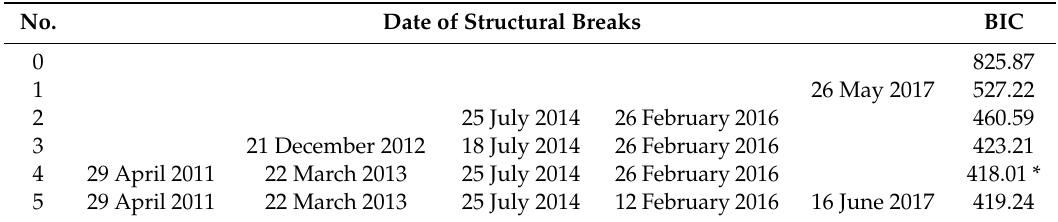
Table 2. Result of structural break analysis of US ethylene crude oil and natural gas prices.